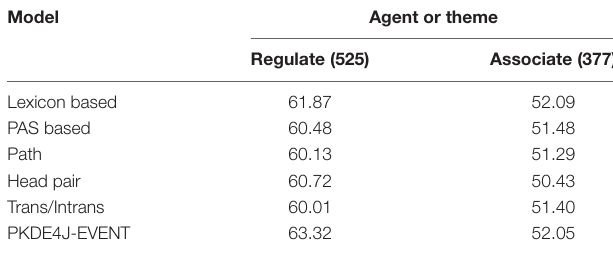
TaBle 8 | Performance results of seven algorithms for cases involving two predicates.